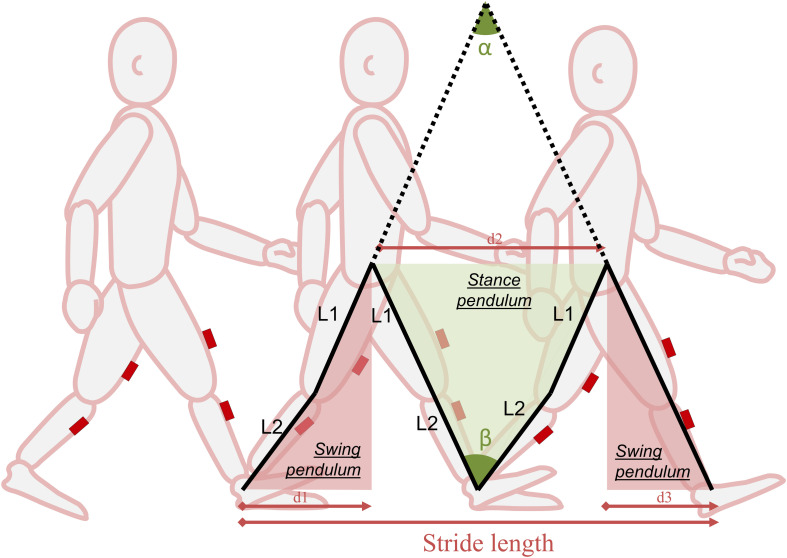
The double pendulum model. The double pendulum model estimates the stride length from the distances d1, d2, d3. d1 and d3 are estimated from α, which is obtained from the angular velocity signal of the thigh (during the swing pendulum) and the segments length (L1, L2); d2 is estimated from β, which is obtained from the angular velocity signal of the shank (during the stance pendulum) and the segments length (L1, L2). For more information, refer to Aminian et al. (2002).